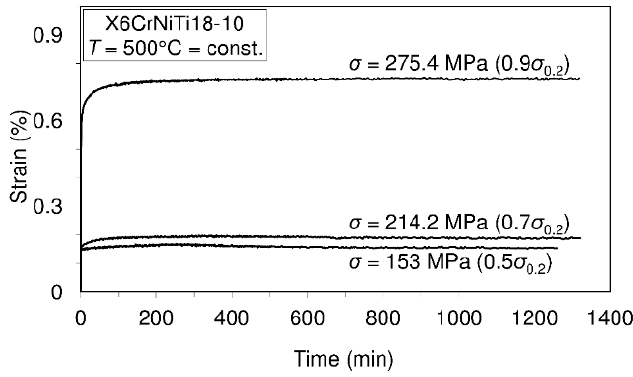
Figure 6. Creep behavior of steel X6CrNiTi18-10 at a temperature of 500 °C.